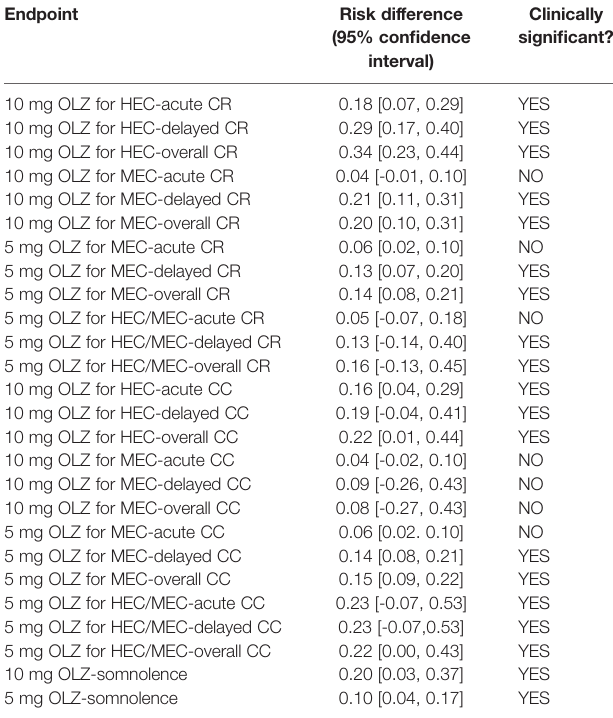
TABLE 3 | Absolute risk difference between olanzapine and other regimens for statistically signi fi cant differences. Endpoint